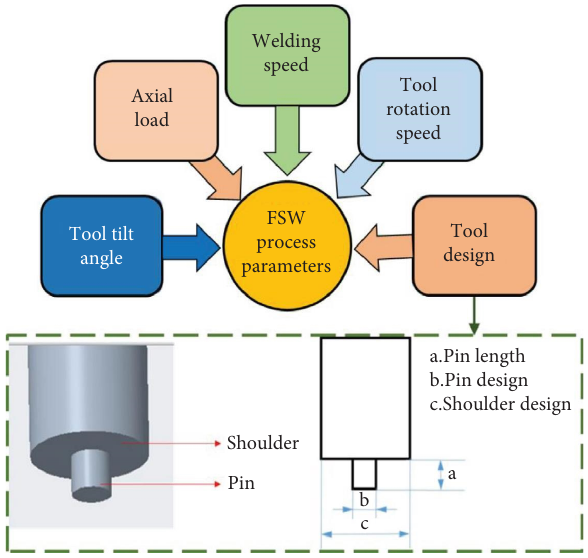
Figure 4: Schematic showing the FSW process parameters and tool